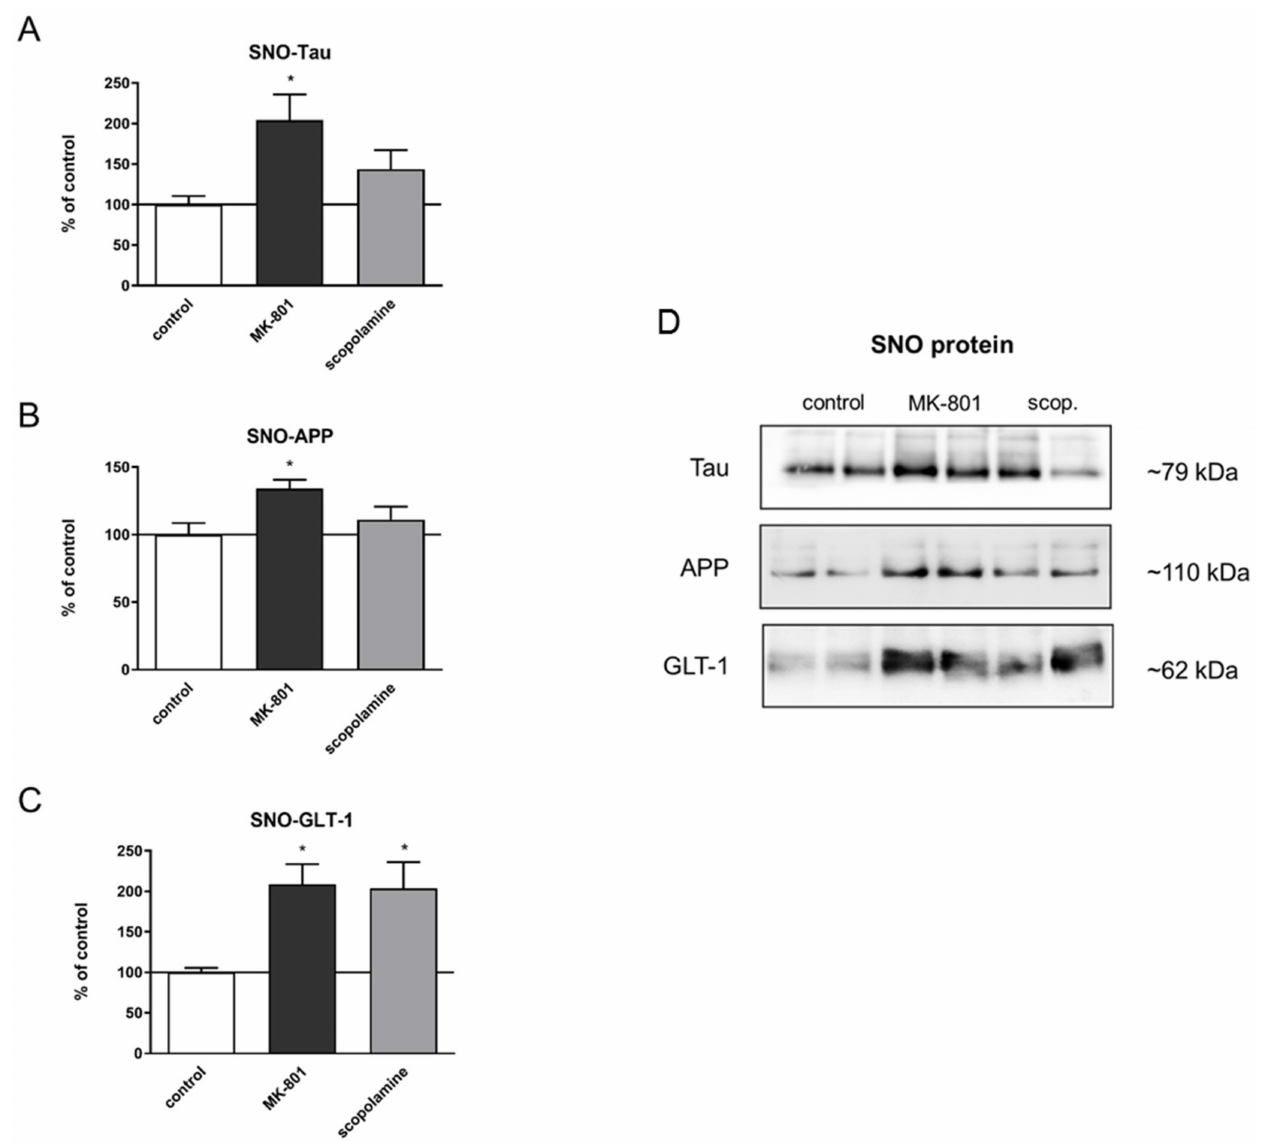
Figure 21. Densitometric analysis of SNO-proteins ( A – C ), equal volumes of eluates from the streptavidin resin were loaded into acrylamide gels. Representative Western blots ( D ). Data are presented as means ± SEM. * p < 0.05 compared to the untreated control